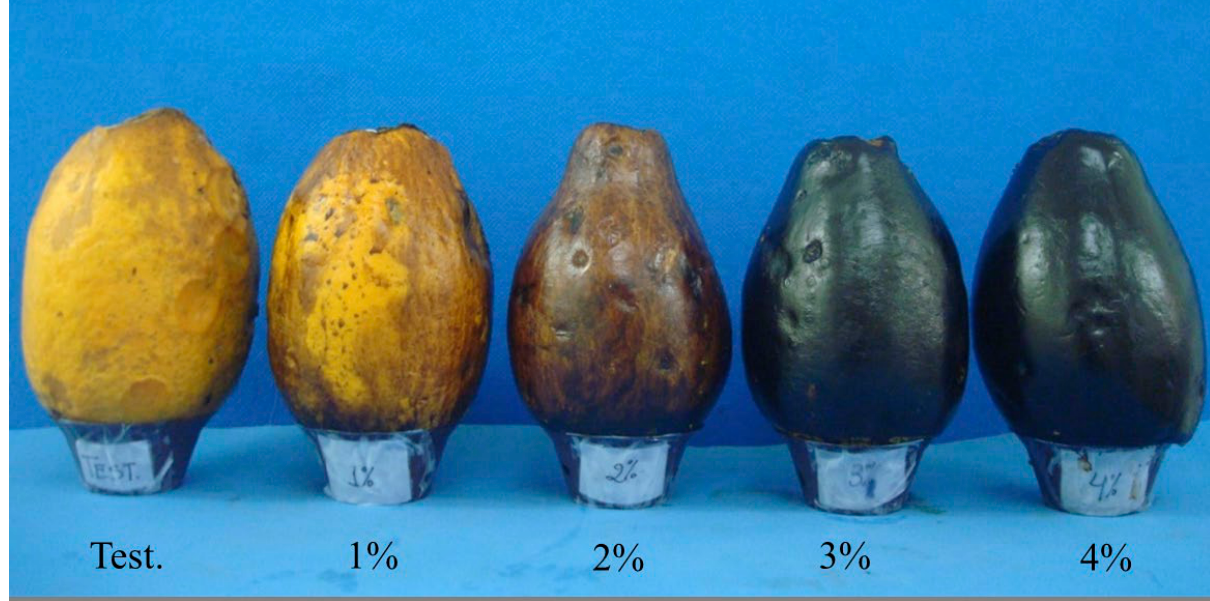
Figure 4. Papaya fruits treated with 2% iodine solution for evaluation of uniformity of distribution of cassava starch coat- ings.